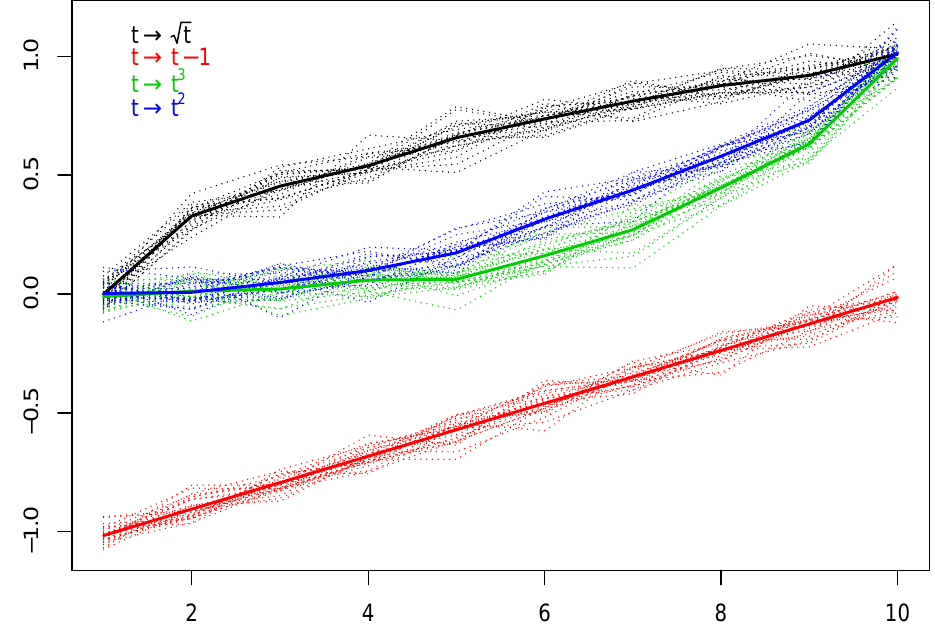
Figure 2. All curves (dotted lines) and cluster centres curves (plain lines) obtained with distclust algorithm for Sample 1. The algorithm correctly clusters’ curves and retrieves the underlying shapes of generating